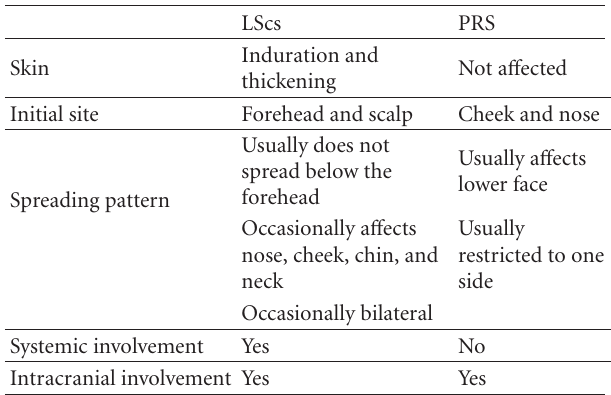
Table 2: Clinical aspects of linear scleroderma en coup de sabre (LScs) and Parry-Romberg syndrome